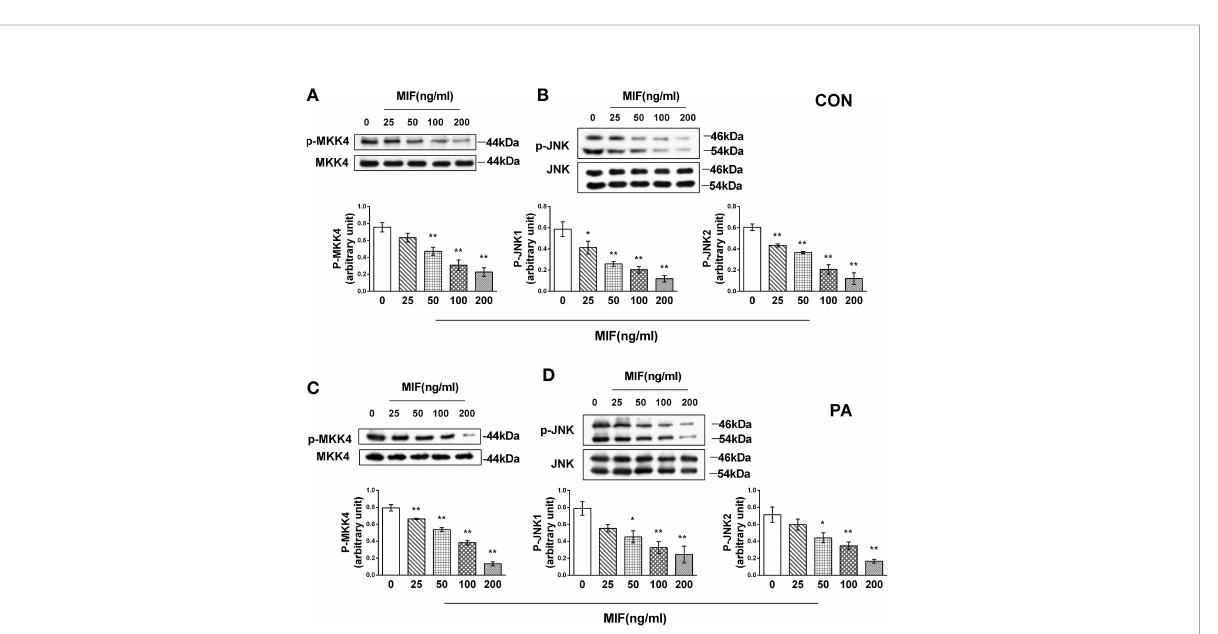
FIGURE 5 rMIF supplementation regulates MKK4/JNK pathway in PA-treated or not HepG2 cells. Gradient concentrations of rMIF (0, 25, 50, 100, 200 ng/ ml) were used to stimulate HepG2 cells for 24 h Protein expression levels of phosphorylated and total MKK4 (A) and JNK (B) were detected by Western blot analysis. HepG2 cells were administrated with 400 mmol/L PA for 24 h and then cultured with the indicated concentration of rMIF, phosphorylated, and total protein expression of MKK4 (C) and JNK were measured (D) ( n = 3 per group). Quanti fi cation of immunoblots is shown in the graphs below the blots. M ± SEM. * P < 0.05 versus Con; ** P < 0.01 versus